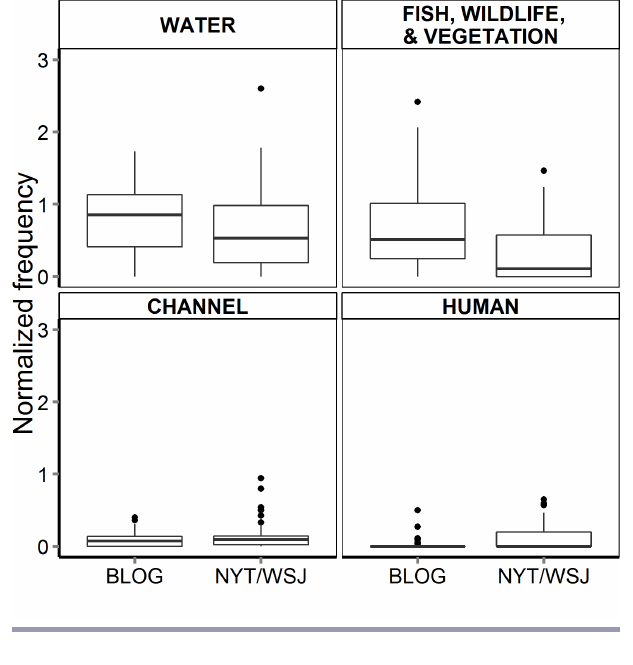
Fig. 3 . Attribute category box plots, see Figure 1 for codes contained within each category.